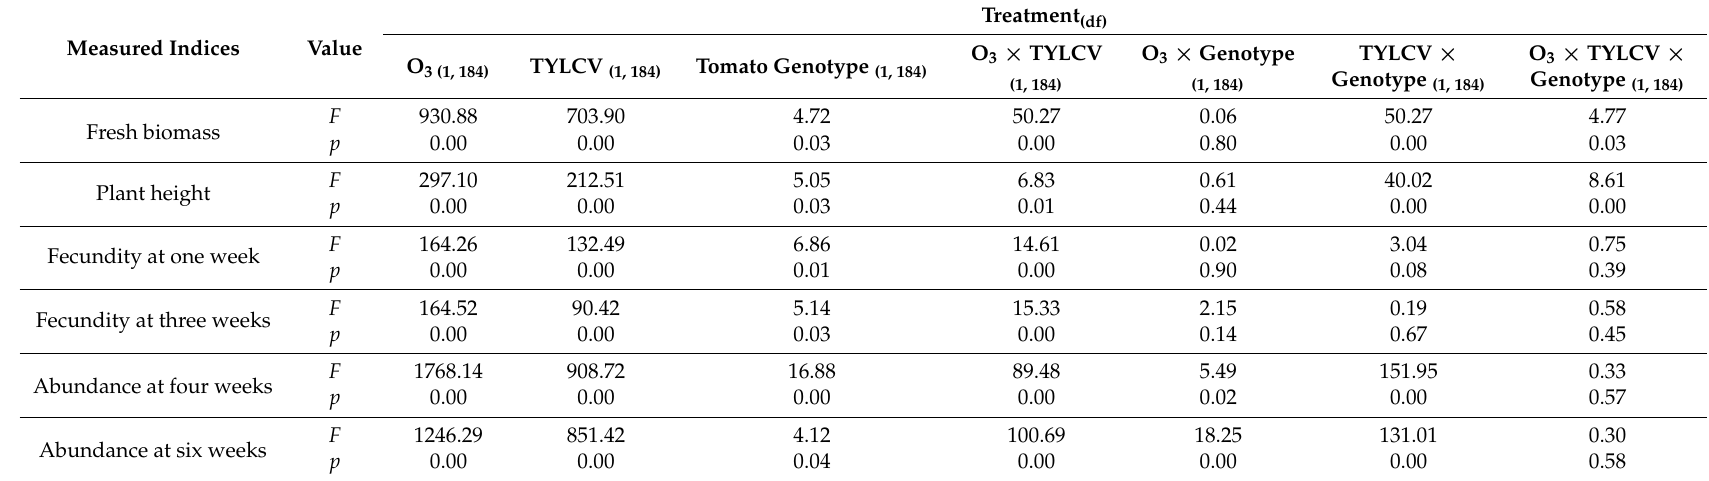
Table 1. Effects of O 3 level, TYLCV infection, and plant genotype on B. tabaci fecundity (egg/pair) and abundance (number/plant), plant fresh biomass, plant height of tomato. F and p values from ANOVA are